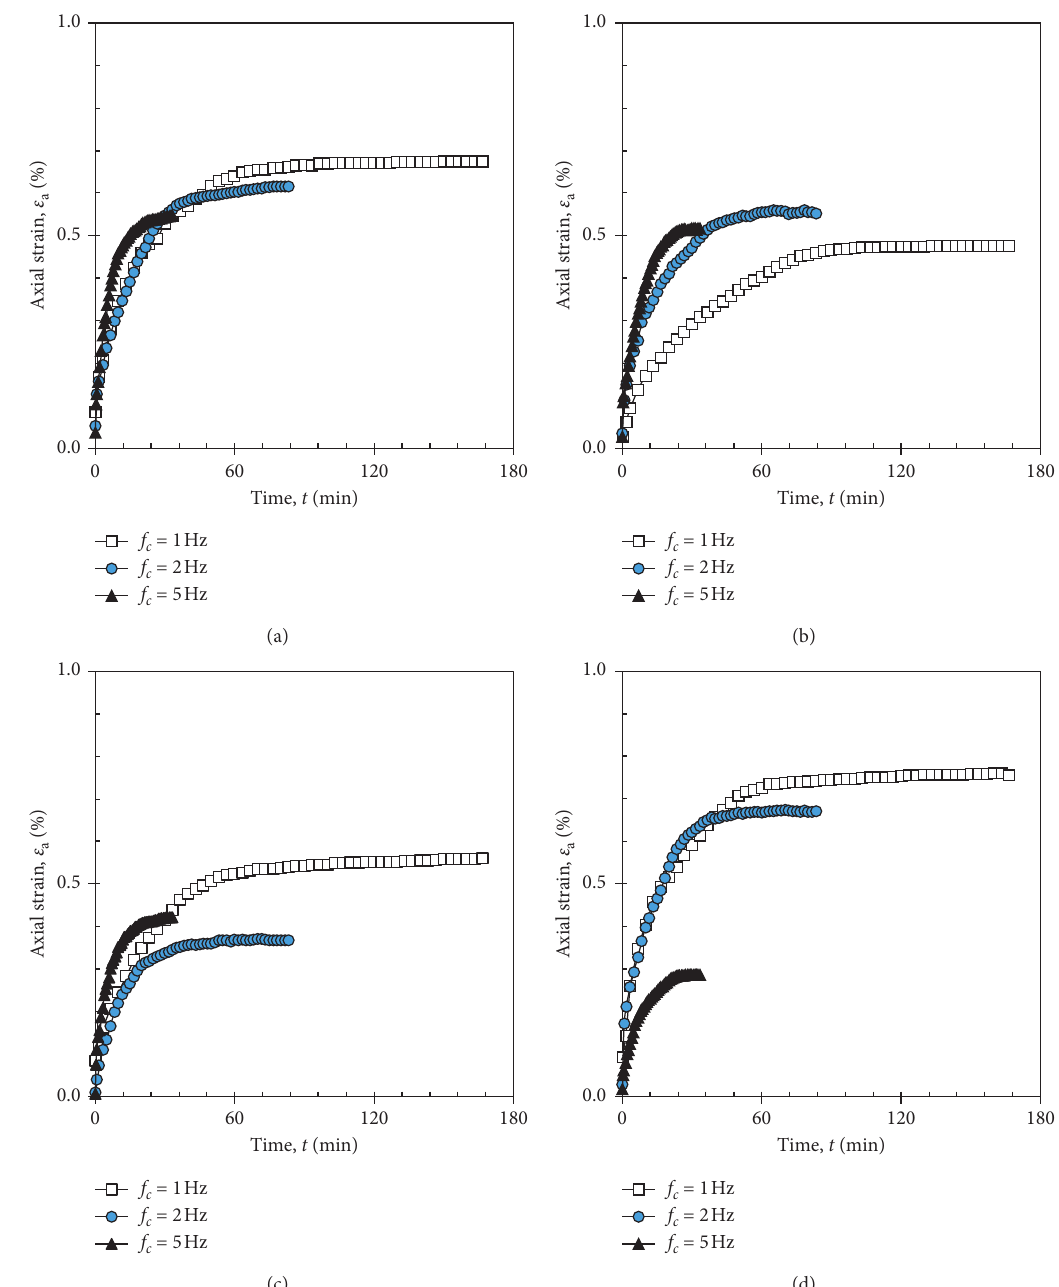
Figure 11: Variation of ε a with t on VDM-treated specimens at f v of (a) 0 Hz, (b) 1 Hz, (c) 2Hz, and (d) 5